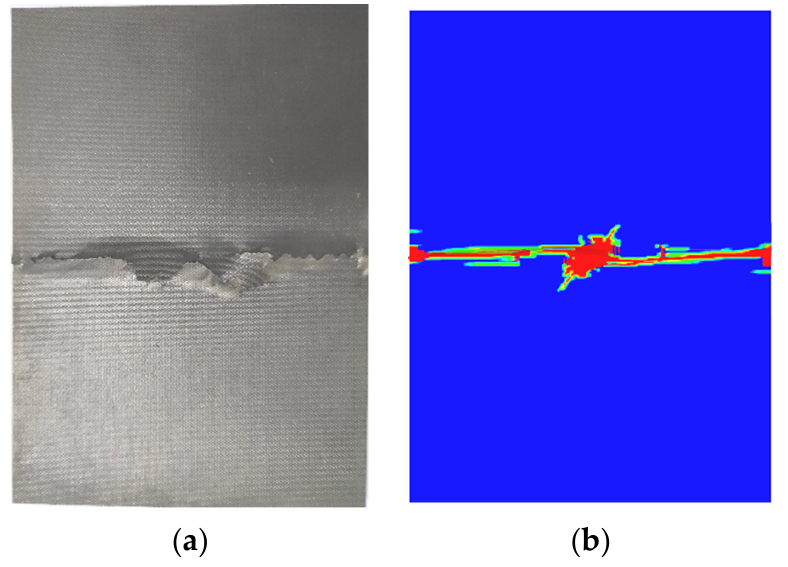
Figure 4. Images of specimens after compression failure. ( a ) Experimental compression failure. ( b ) Predicted compression failure.